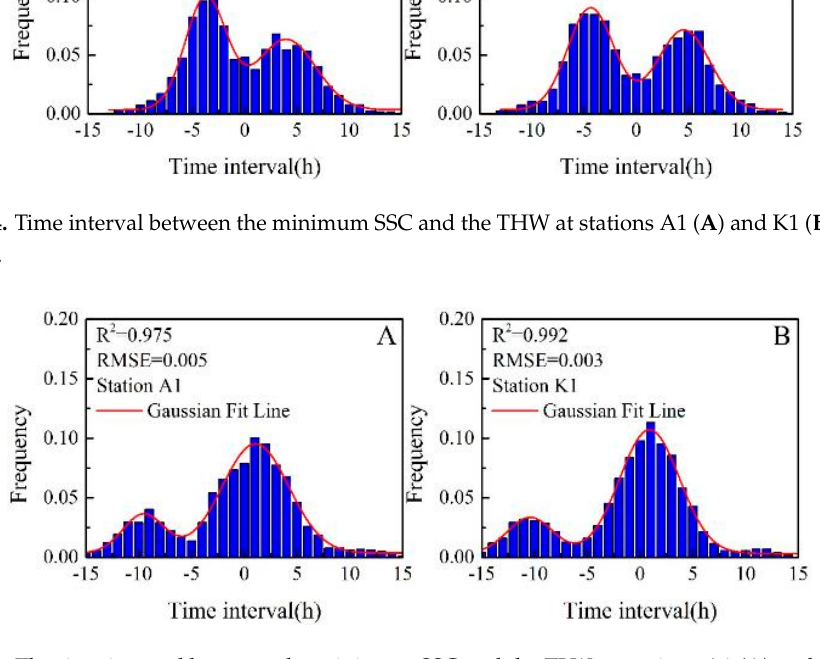
Figure 15. The time interval between the minimum SSC and the TLW at stations A1 ( A ) and K1 ( B ) in 2007 and 2008. Table 5. Gaussian fit results of the frequency between the time of minimum SSC and THW or TLW.